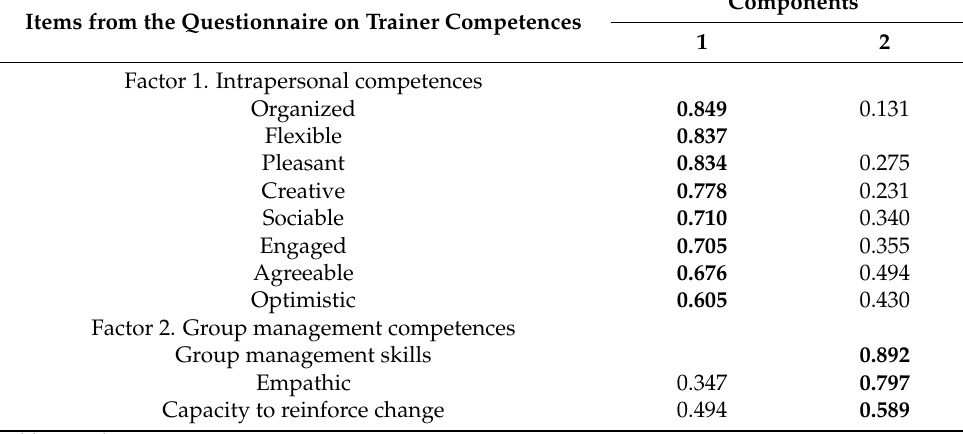
Table 2. Factor loadings of the items for each of the obtained components. Items from the Questionnaire on Trainer